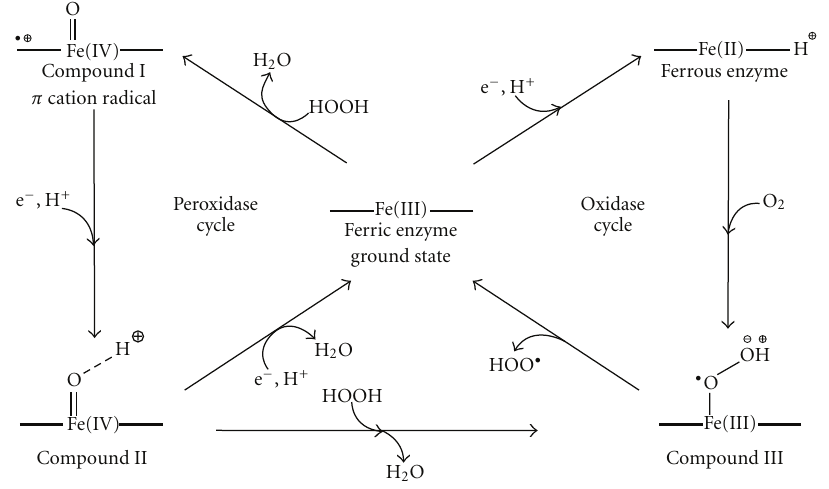
Scheme 1: The five oxidation states of